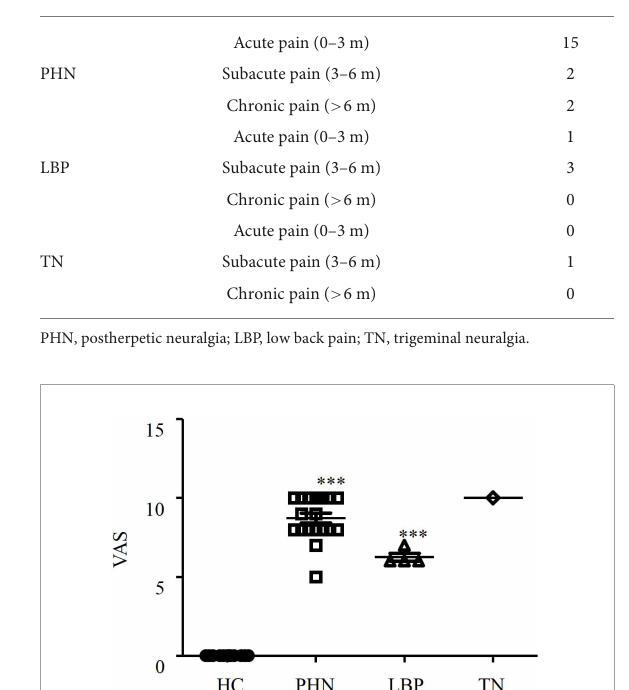
TABLE 2 Classification of patients with pain as acute, subacute, and chronic pain.